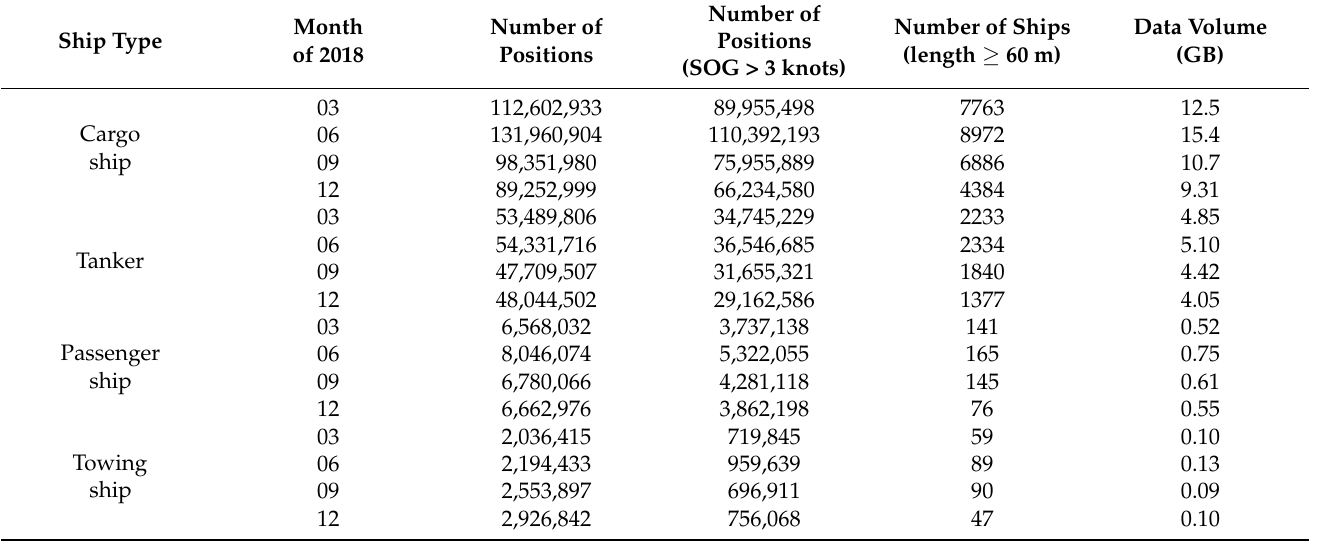
Table 3. Basic characteristics of the AIS data used for